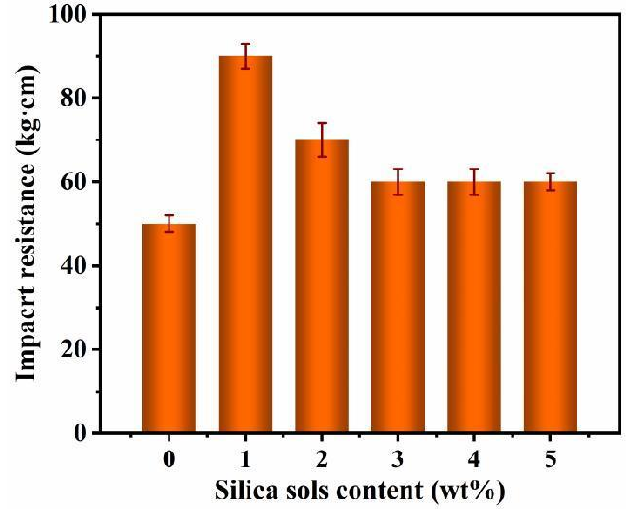
Figure 7. Effect of silica sol content on the impact resistance of UV-curable WA coatings.